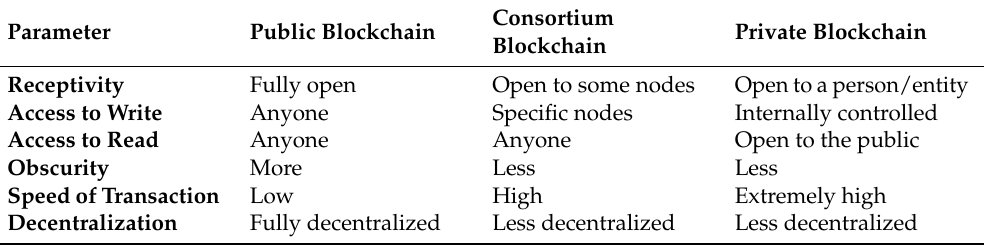
Table 1. Classification of blockchains [25–31].